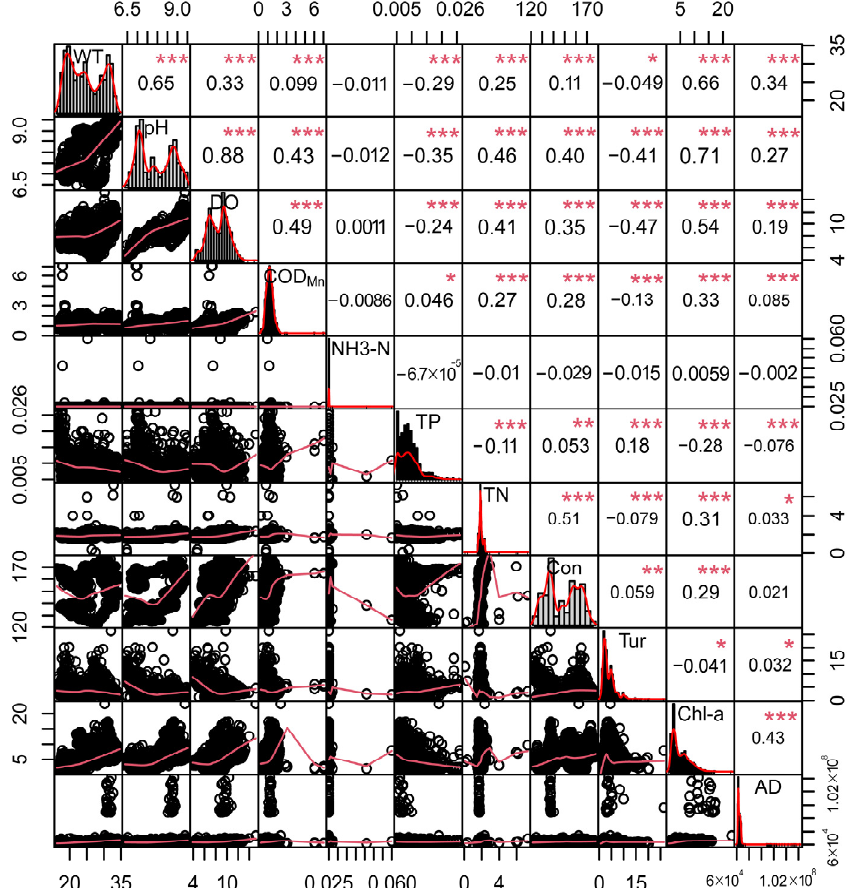
Figure 11. Correlation coefficient diagram between WQPs. Con, conductivity, Tur, turbidity, AD, algal density. The diagonal line gives the distribution, histogram, and density curve of WQPs. The lower triangle (the lower-left corner of the diagonal) gives the scatter diagram and the upper triangle (the upper-right corner of the diagonal) between the two WQPs. The value represents the correlation coefficient of the two variables. The larger the value, the greater the correlation degree; the asterisk indicates the degree of significance, * indicates p < 0.05, ** indicates p < 0.01, *** indicates p < 0.001.